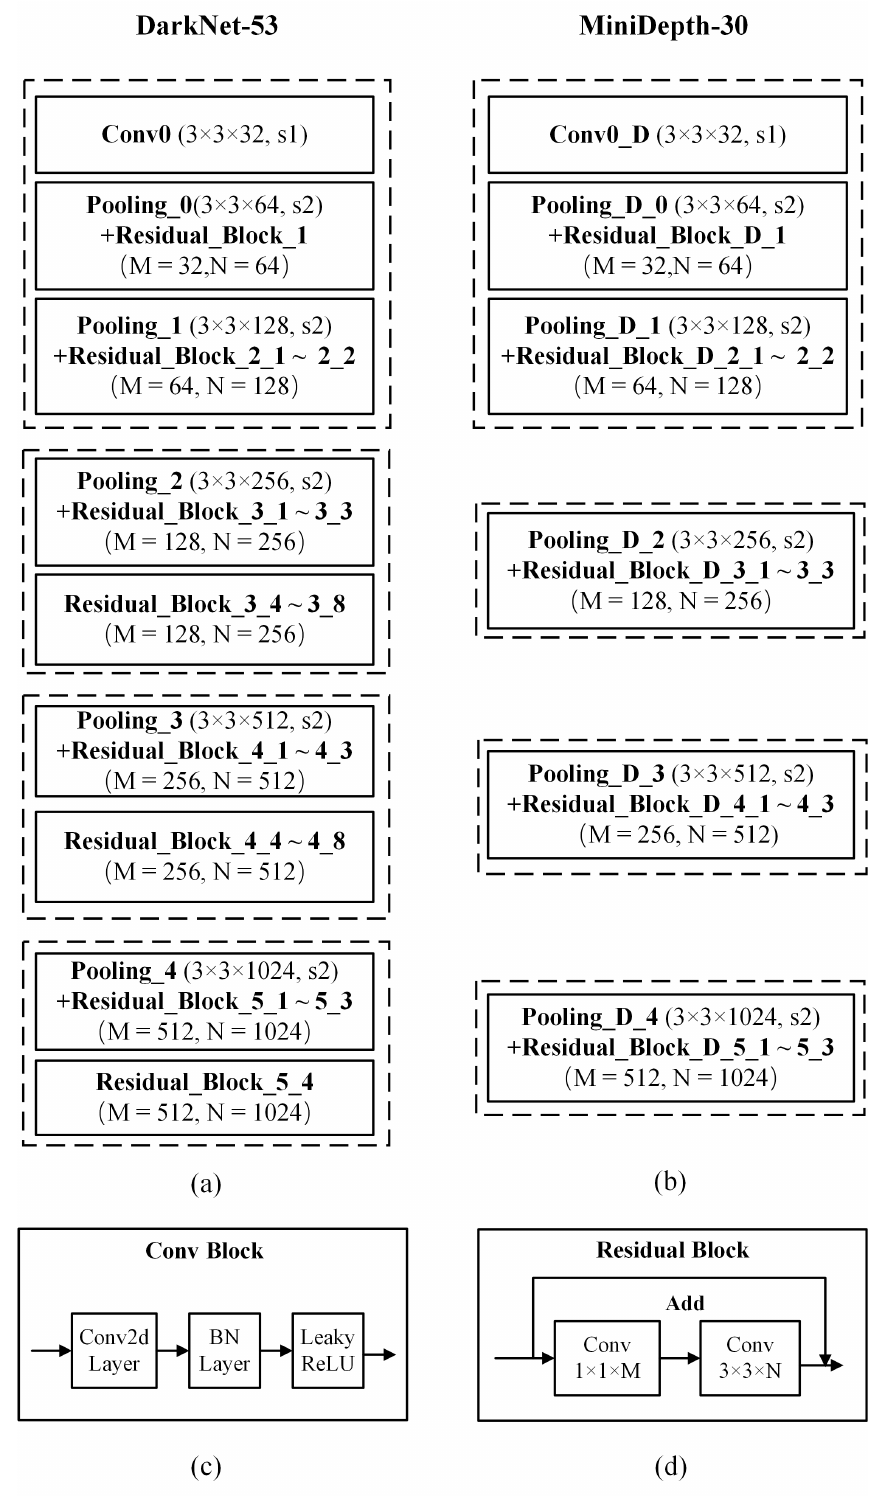
Figure 3. The structure of the asymmetric two-stream network proposed in this paper, showing of the network architecture and main components: ( a ) Darknet-53, ( b ) MiniDepth-30, ( c ) a convolutional layer, and ( d ) a residual